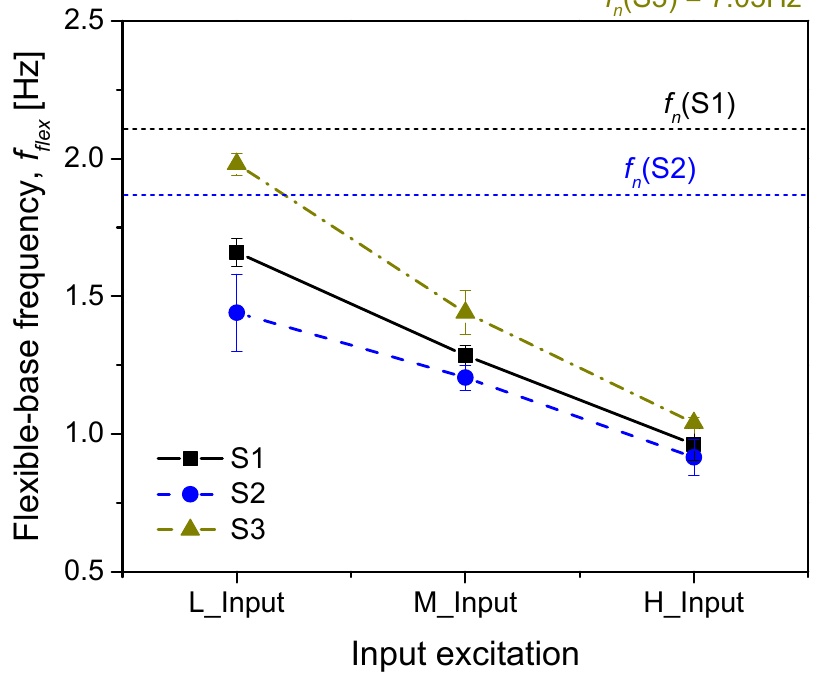
Figure 6. Variation of flexible‐base frequency ( f flex ) of S1, S2, and S3 structure with level of input excitation. f n indicates fixed‐base frequency of each structure. Average value from two input motions was plotted. Error bars indicate variations of two motions.